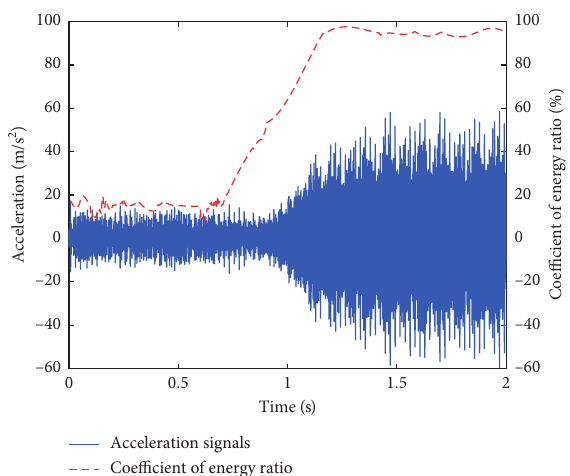
Figure 9: Variation trend of T 1 in the chatter-generating processes.